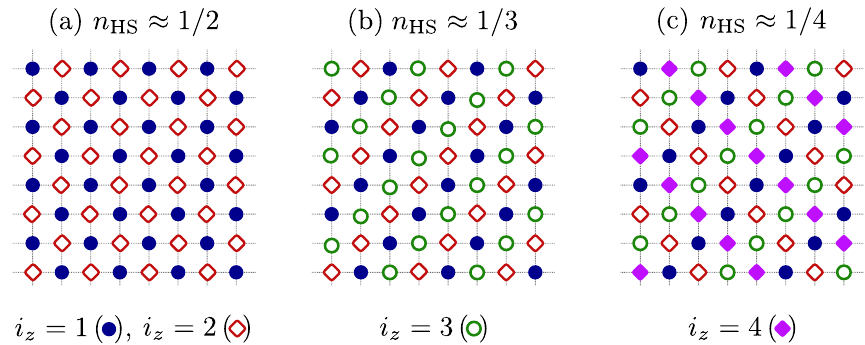
Figure 6: Configurations of HS states in the 3D lattice at fillings 1 / 2, 1 / 3, and 1 / 4, where the states, which occupy 2D layers with different i